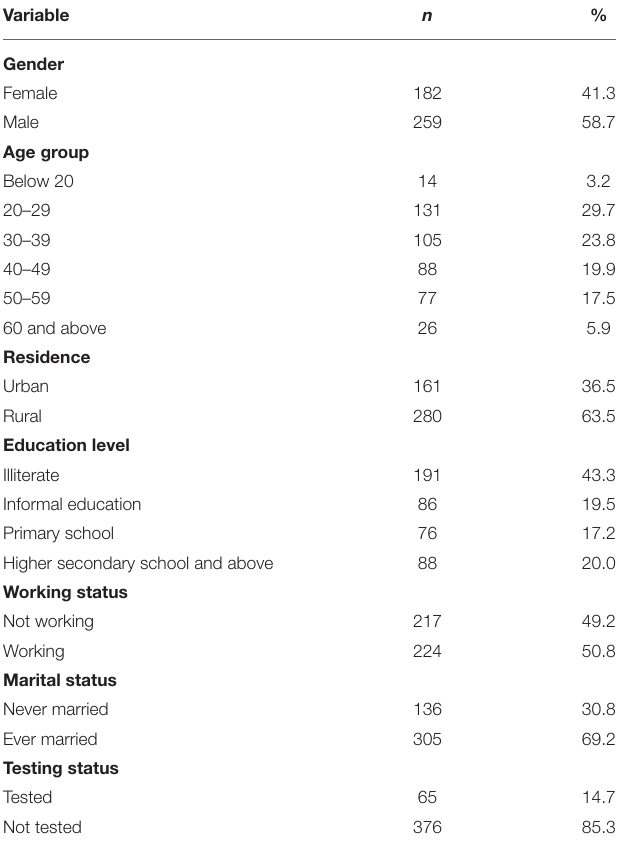
TABLE 1 | Socio-demographic characteristics of study participants ( N =